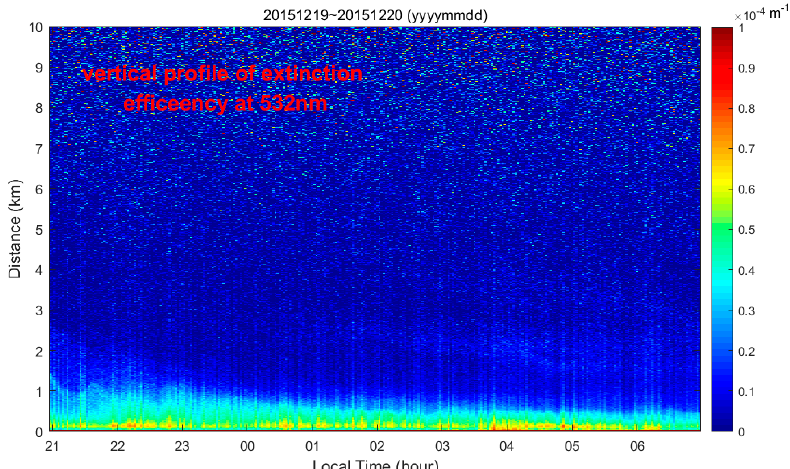
Figure 10. Spatial and temporal evolution of the lidar in the night. The color bar represents the extinction coefficient, and its unit is m -1 .